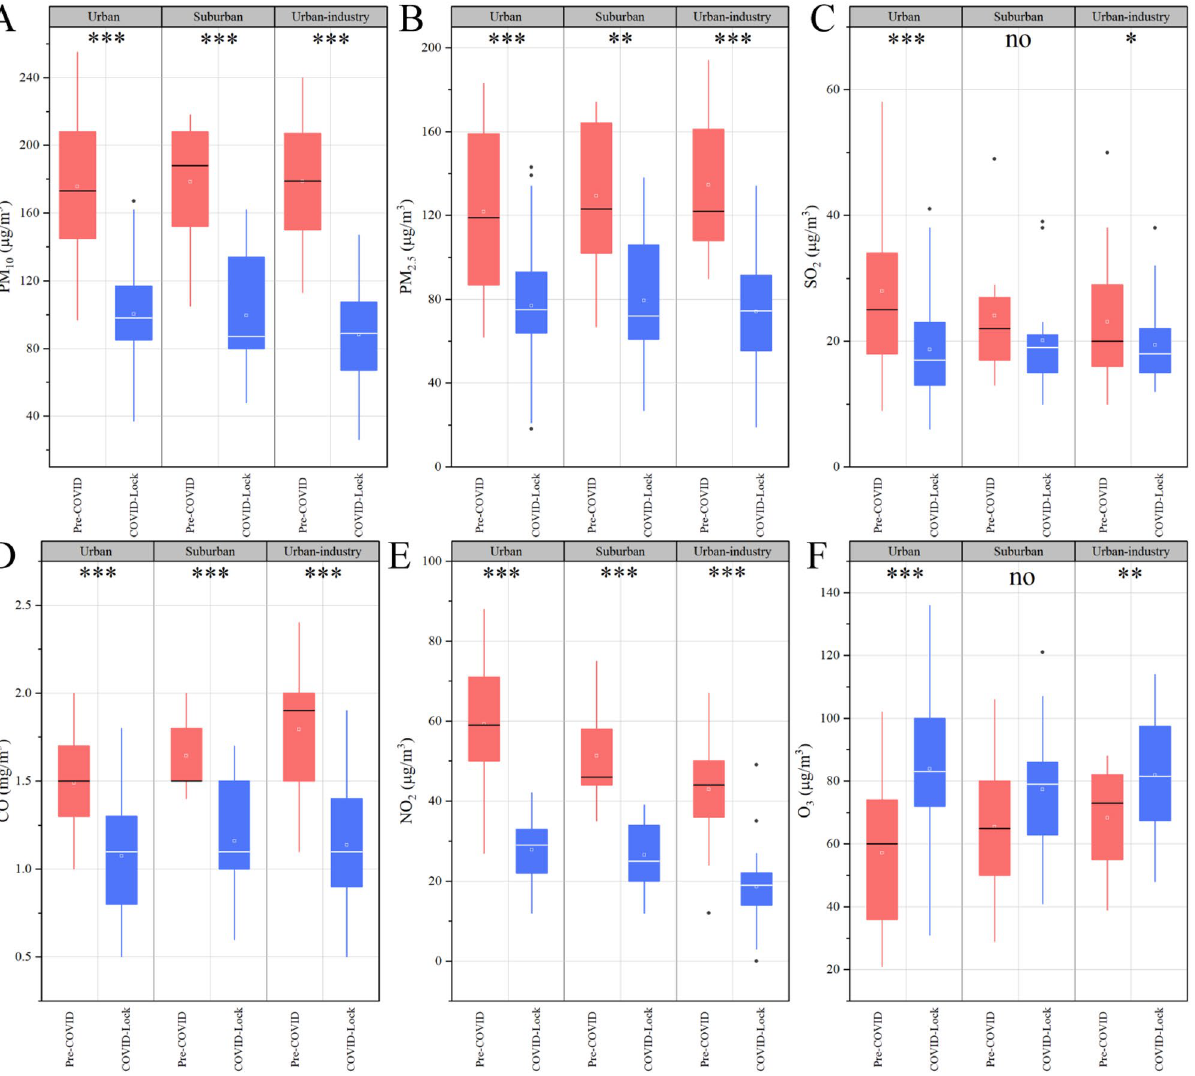
Figure 3. Mean concentrations (± SD, mg/m 3 ) of PM 10 , PM 2.5 , NO 2 , SO 2 , CO and O 3 during the pre-COVID and COVID lockdown periods in 2020; the values were determined by combining the urban, suburban and urban-industrial areas at the regional scale. *, ** and *** represent significant differences between the pre- COVID and COVID lockdown periods in the same region (Duncan test, *p = 0.05; **p = 0.01; ***p = 0.001), with nonsignificant results being